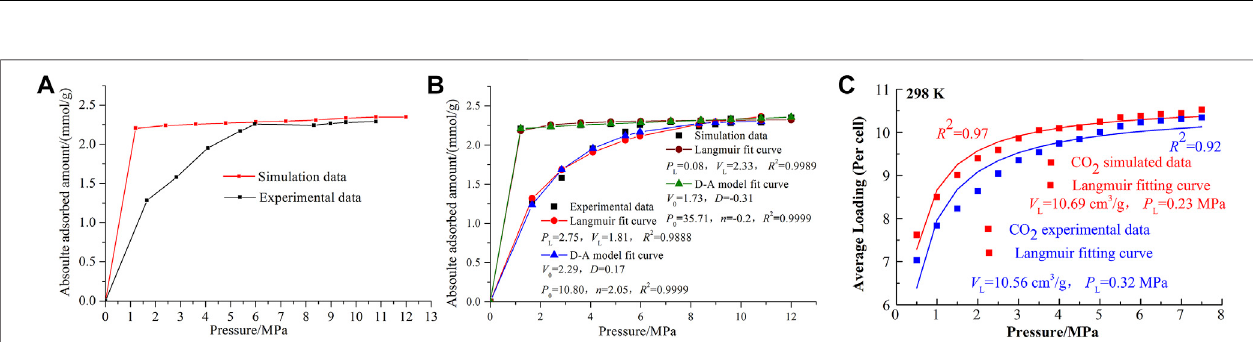
FIGURE6|(A) ComparisonbetweenMDandexperimentresultsforCH 4 , (B) theirLangmuirandD-Amodel fi ttingresults(Songetal.,2017a),and (C) comparison between MD and experiment results for CO 2 (Song et al., 2018).